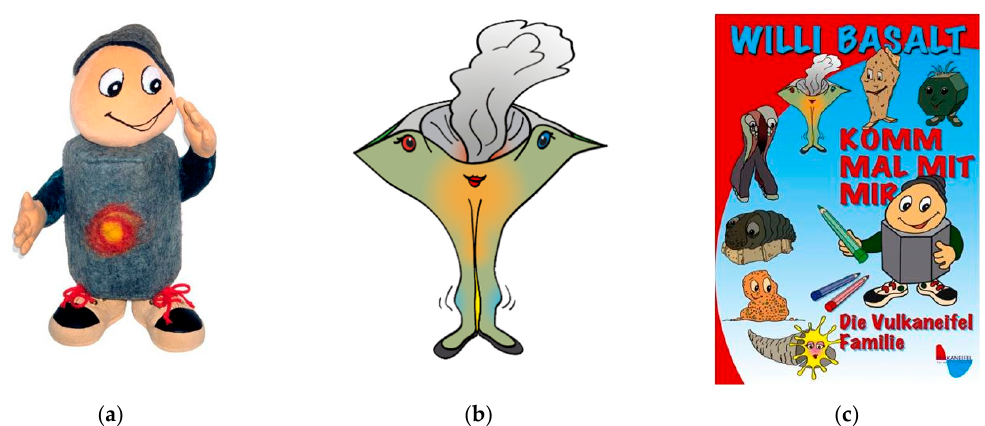
Figure 9. ( a ) Willi Basalt and ( b ) Lisa Maar are members of the Vulkaneifel family, created in 1996 [62]. ( c ) Coloring booklet with Vulkaneifel Family.